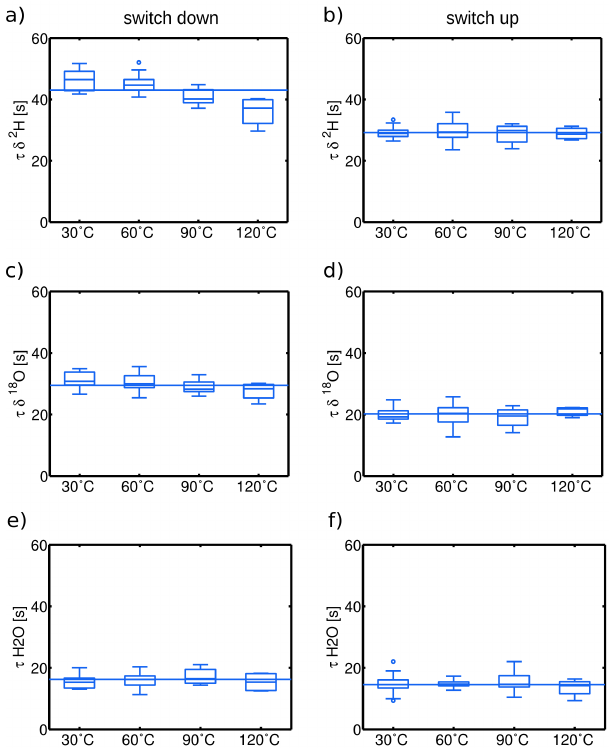
Fig. 12. Typical response times τ ads for the L1115-i isotope mea- surements. The boxplots show the distribution of response times as a function of tubing temperature. The left column of plots shows switches to lower water vapour mixing ratios (switch down) and the right column of plots shows switches to higher water vapour mixing ratios (switch